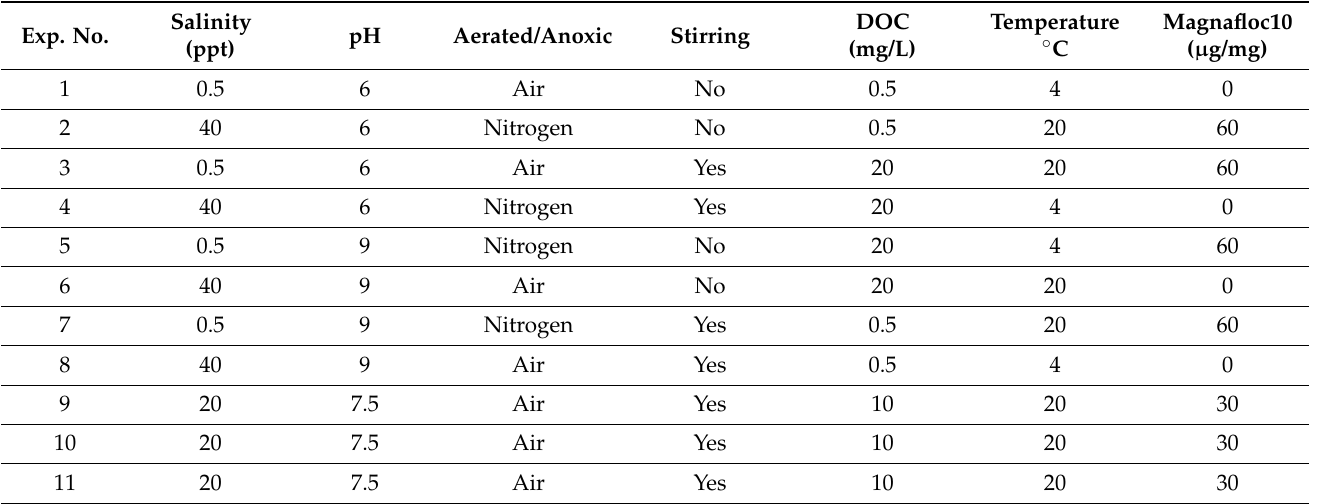
Table 1. Experimental design of the leaching